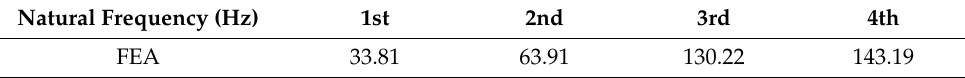
Table 3. The first four natural frequencies obtained by the FEA. Natural Frequency (Hz)